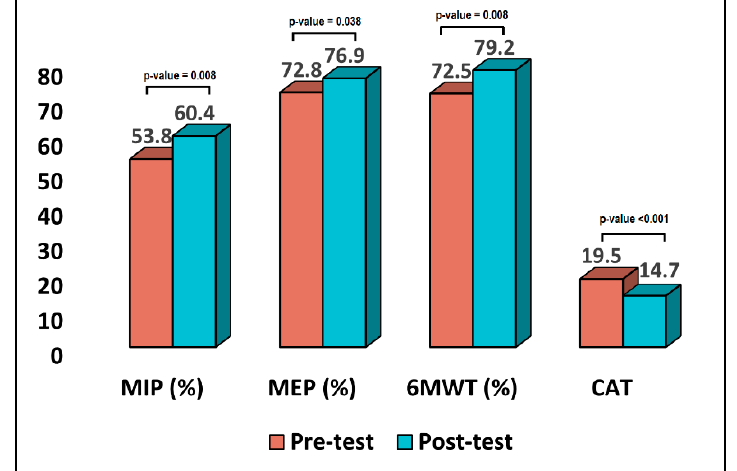
Figure 1. Comparison of pre-test and post-test results in the inpatient setting.